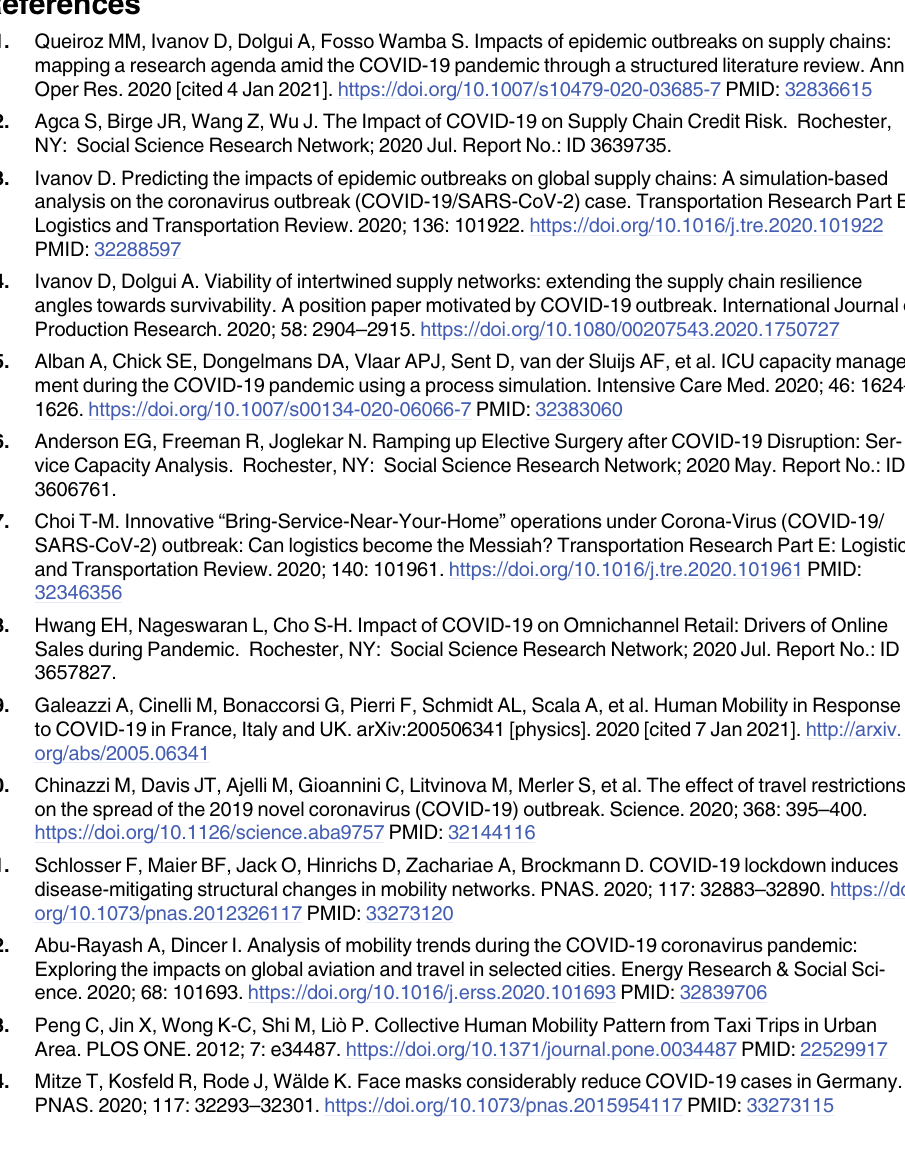
S1 Table. Community area codes and the names of the corresponding community